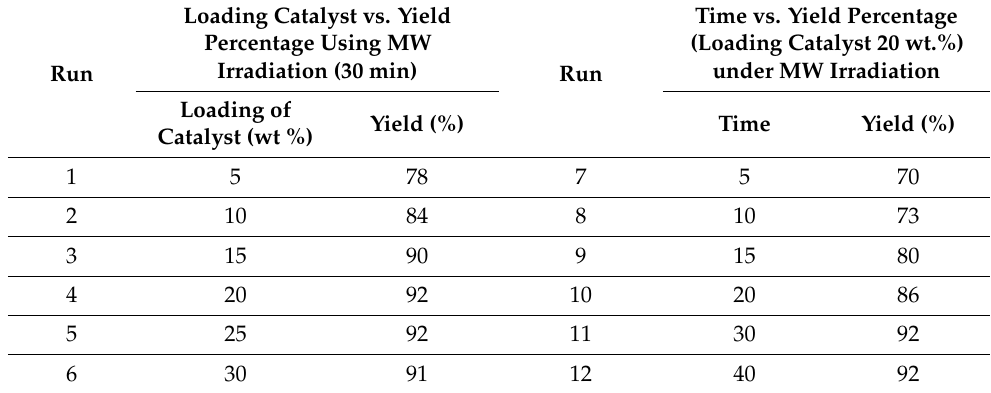
Table 1. Optimizing the catalyst loading and time under microwave irradiation.